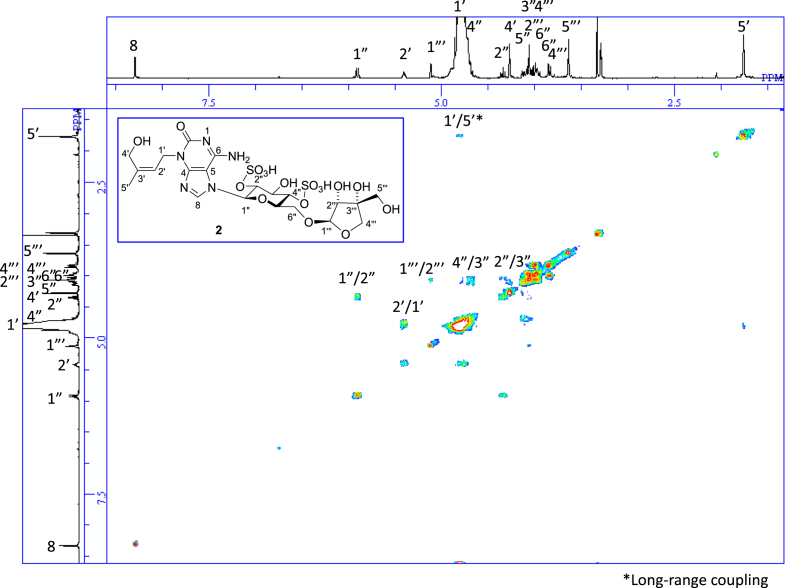
1H–1H COSY of 2.